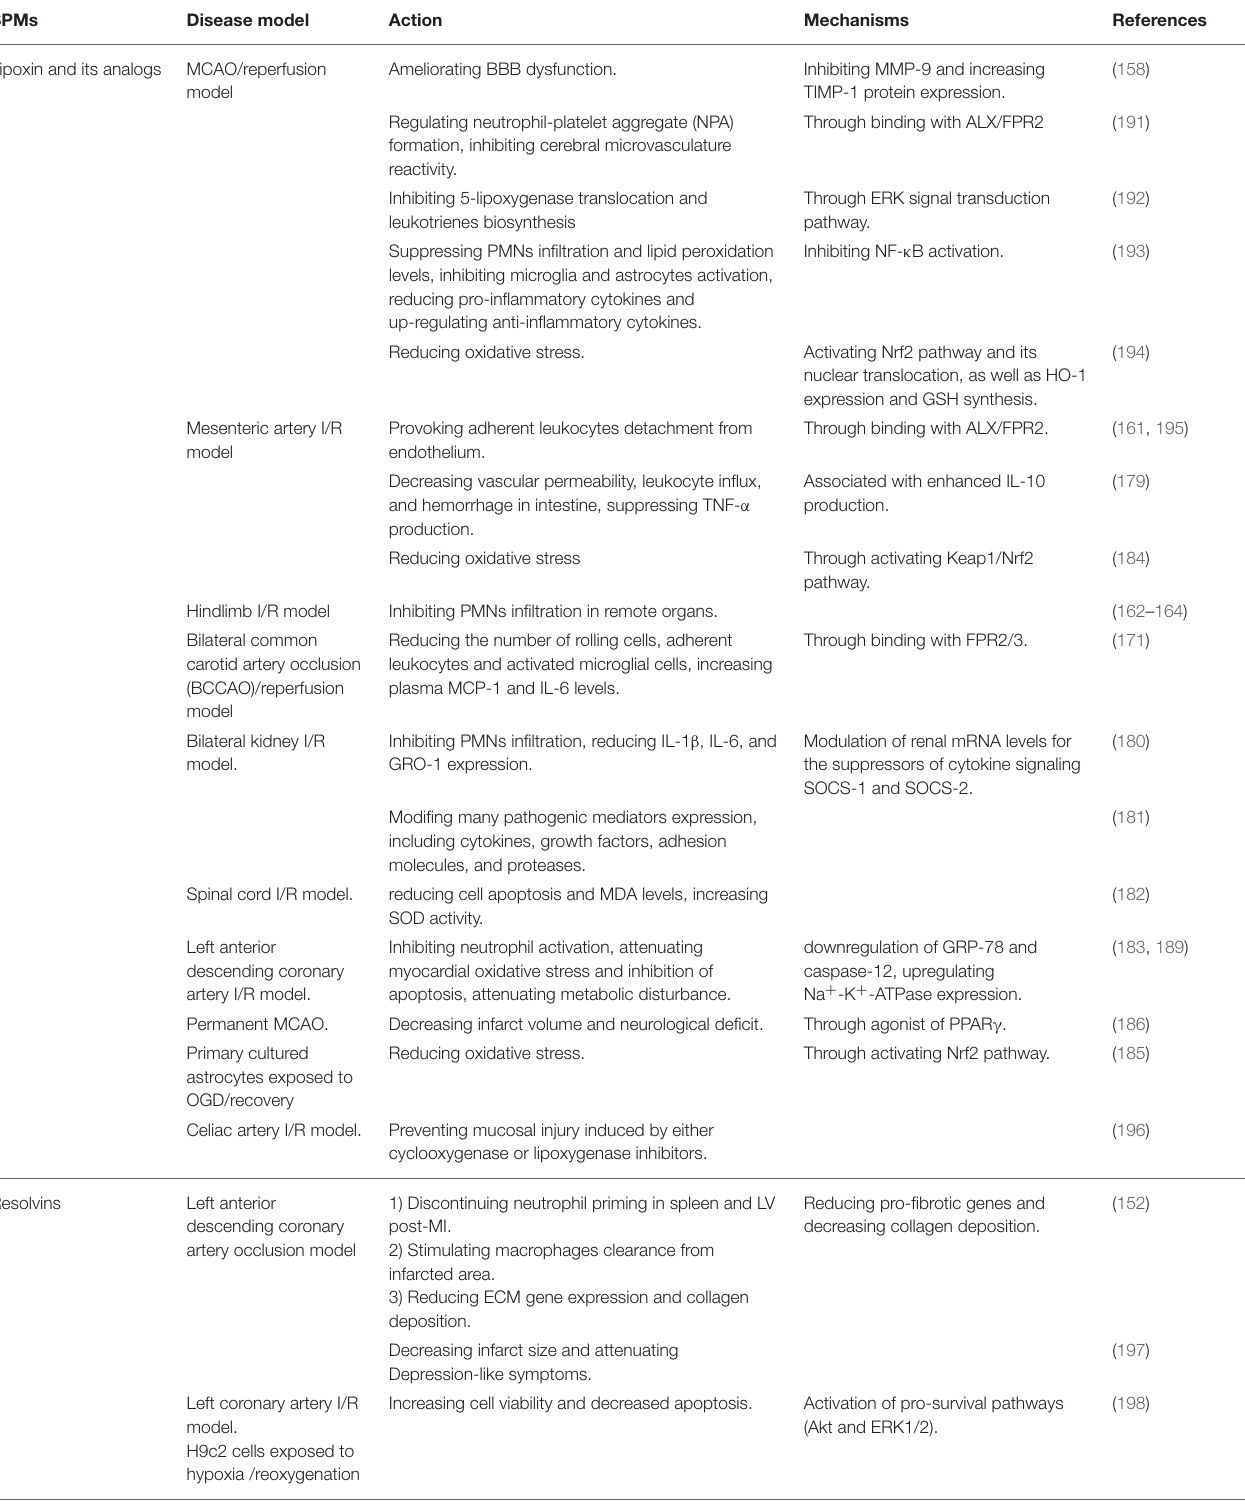
TABLE 1 | Studies of SPMs in I/R injury experiment